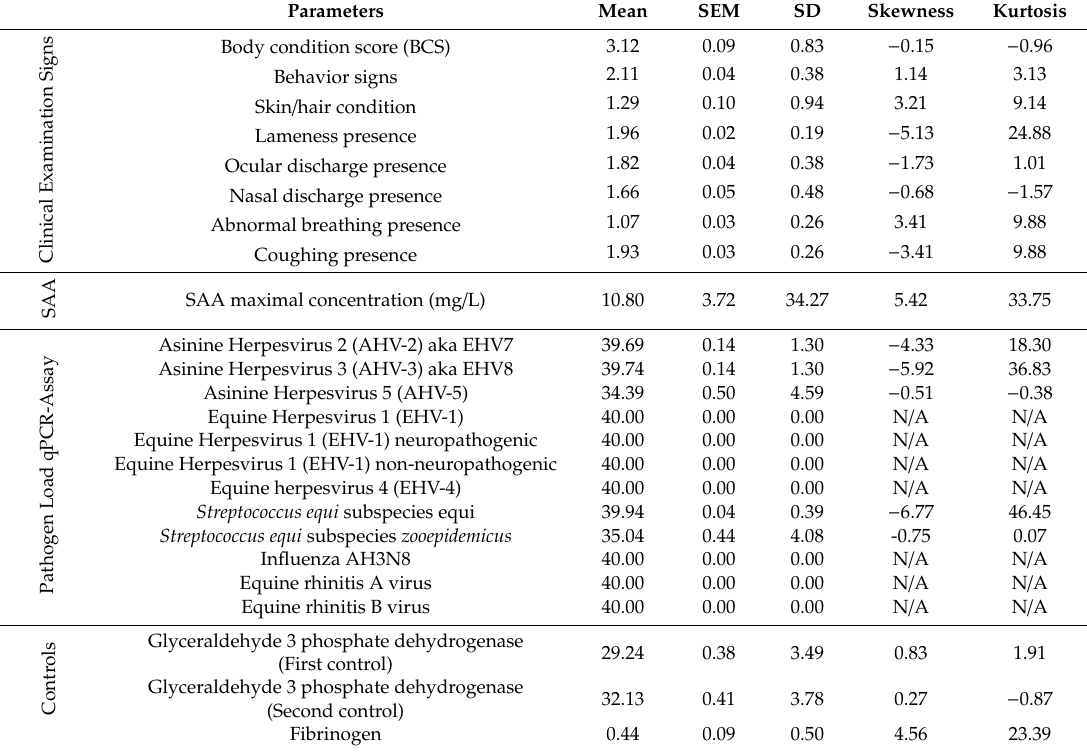
Table 2. Summary of descriptive statistics for clinical examination signs, Serum Amyloid A (SAA) maximal concentration expressed in mg / L, qPCR-assay microbe loads, and controls at sampling moment one. Parameters Mean SEM SD Skewness Kurtosis Body condition score (BCS)